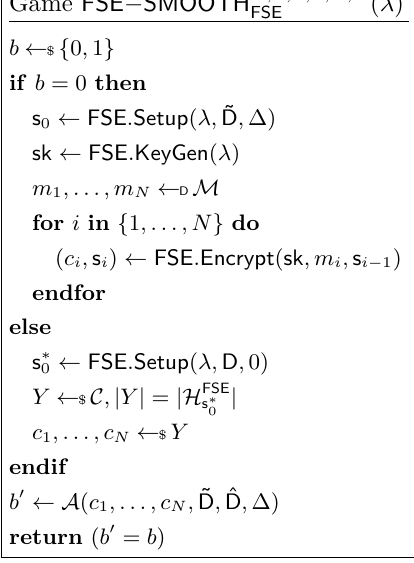
Figure 1: The frequency-smoothing game for an FSE